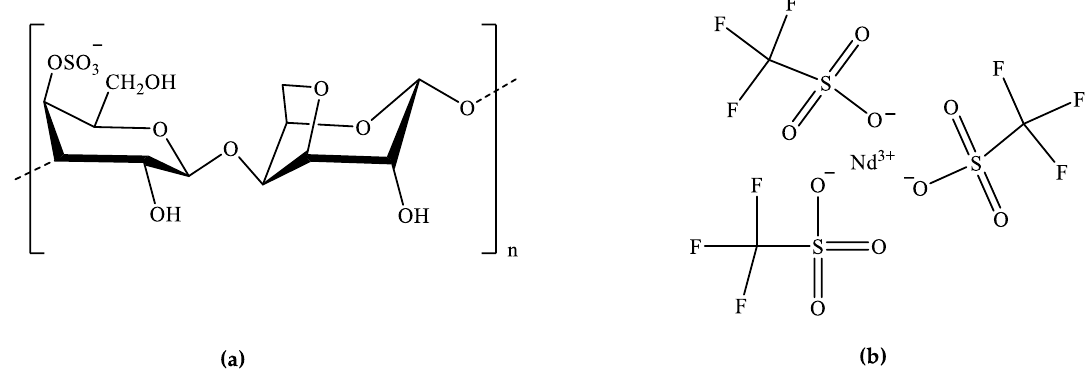
Figure 1. Representation of the chemical structures of κ -carrageenan ( κ -Cg) ( a ) and NdTrif 3 ( b ).